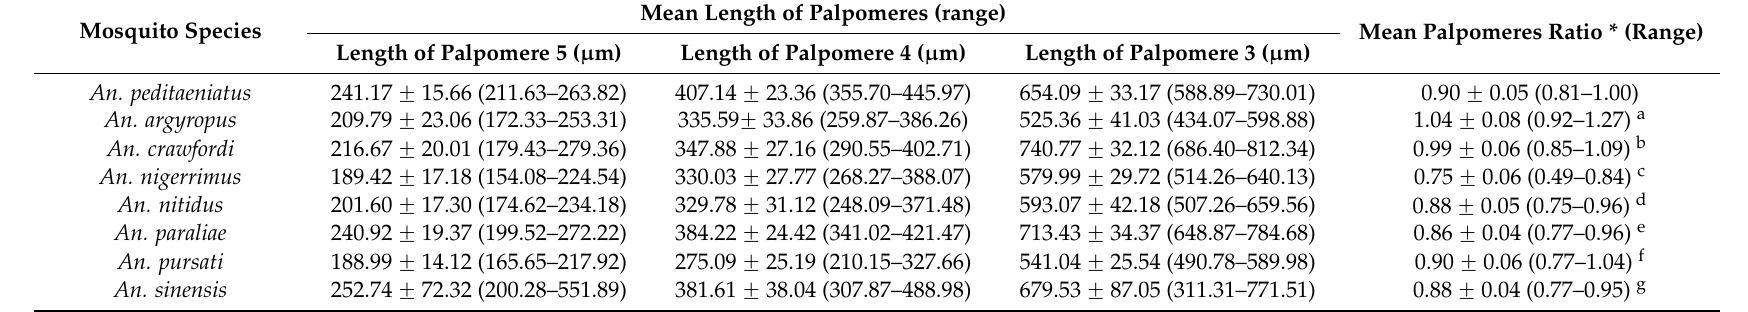
Table 4. Comparisons of the mean palpomeres ratios of females of the eight species of the Hyrcanus Group (30 females/species, n = 60).